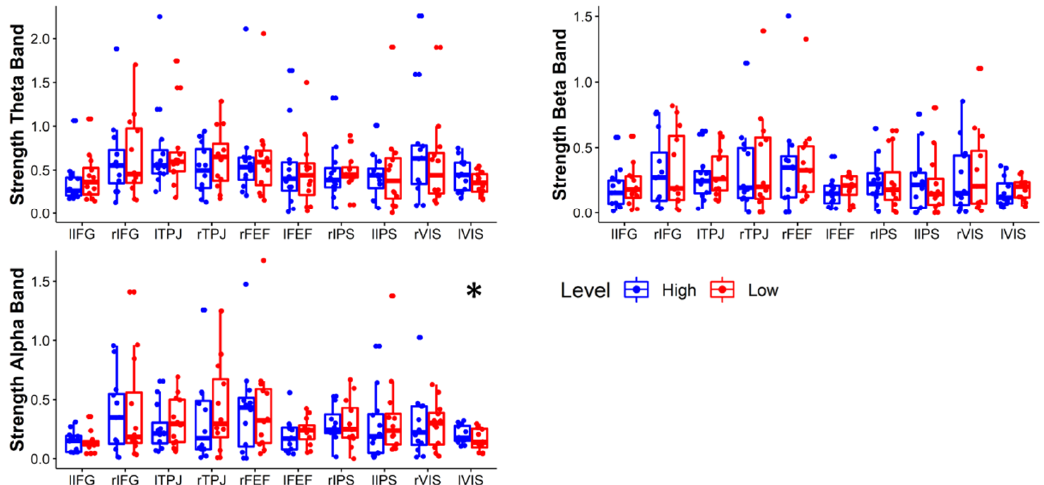
Figure 7. Wilcoxon test of the strength in Theta, Alpha, and Beta bands between Low and High attentional demand. The single asterisk (*) means p < 0.01252 (FDR corrected).